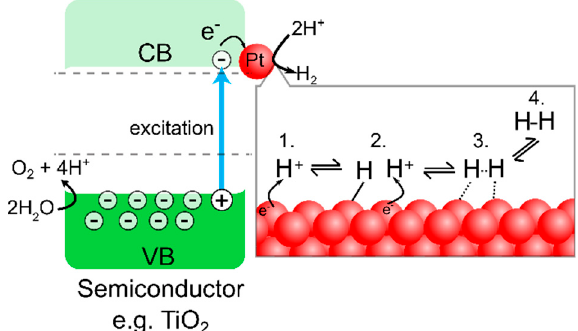
Figure 1. Schematic highlighting the process of water splitting via photocatalysis and the importance of the co-catalyst for the hydrogen evolution reaction (HER). HER follows: (1) Electron transfer from co-catalyst to H + . (2) H adsorption and electron transfer to second H + . (3) Electron transfer between neighbouring adsorbed hydrogen atoms to form chemical bond. (4) Desorption and release of H 2 .